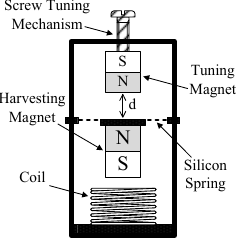
Figure 8. Schematic representation of the magnetic forces based MTT proposed in [8,9].